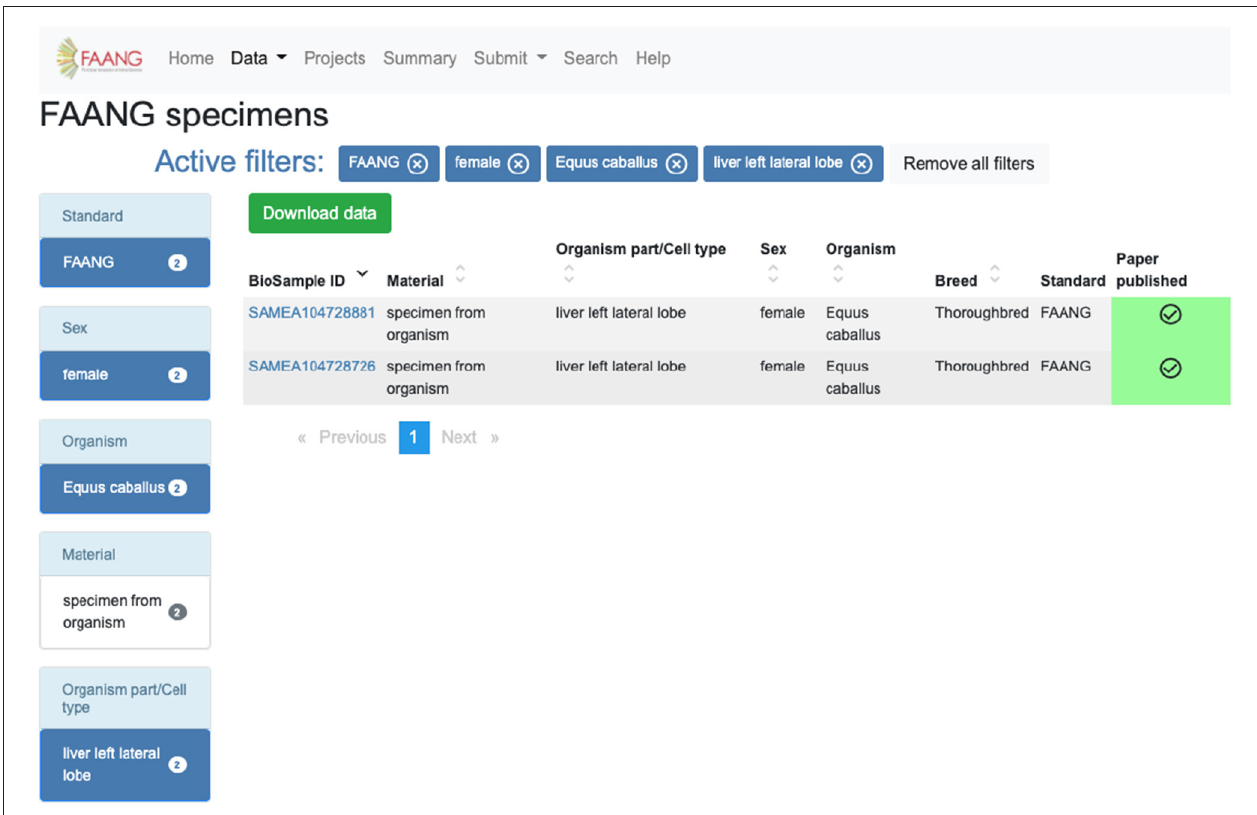
FIGURE 3 | FAANG Data Portal specimen table utilising filters to obtain specimens from Equus caballus females from the liver left lateral lobe (https://data.faang.org/